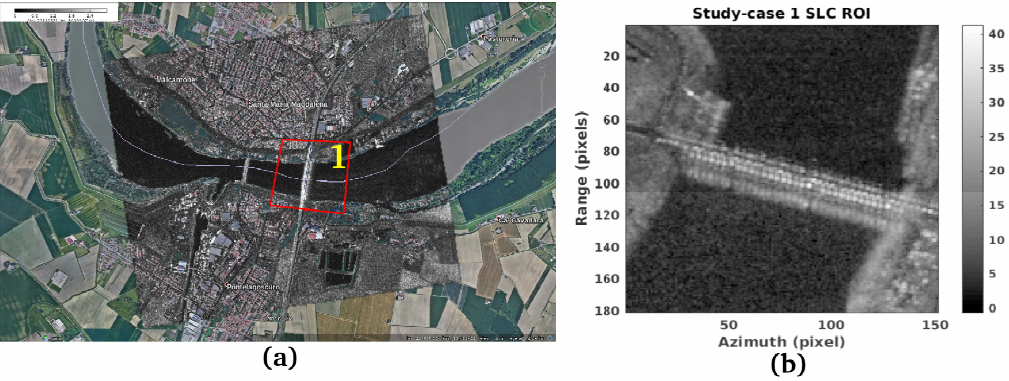
Figure 8. Case study 1 magnitude SAR images. ( a ): Geolocated image with ROI footprint representation. ( b ) Particular of the ROI magnitude in the slant coordinates.